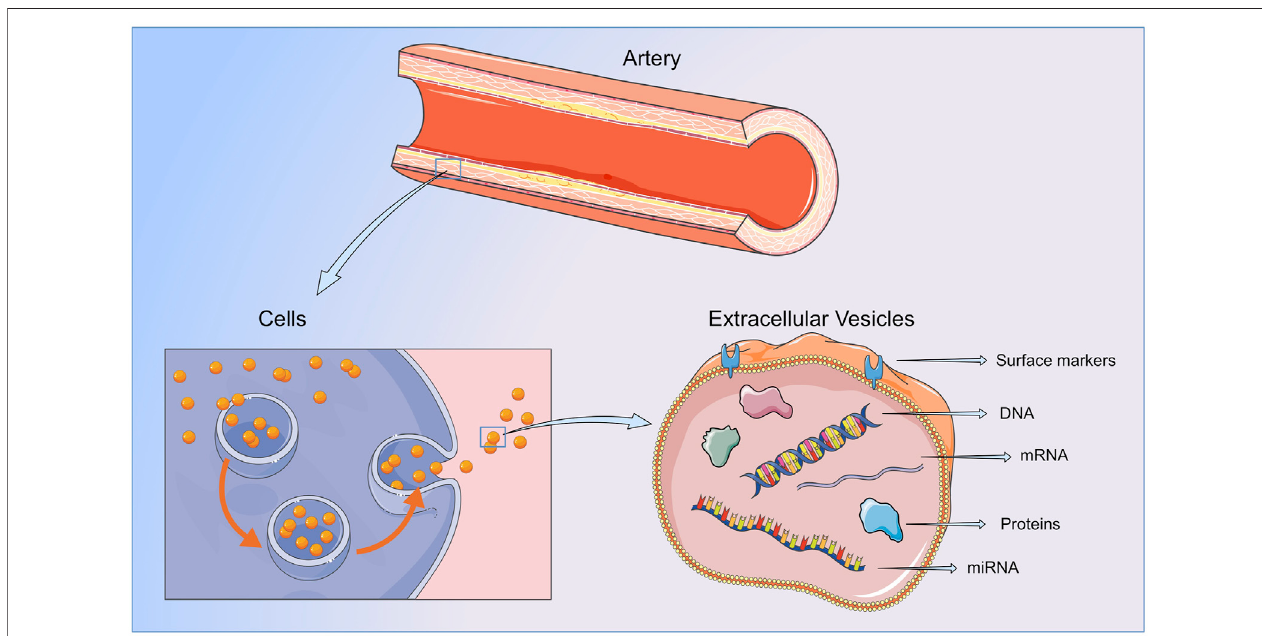
FIGURE 2 | Extracellular vesicles. EVs contain lipids, protein and nucleic acids from the cell or organ of origin and are released to the bloodstream by all cellular componentsofthevasculatureandblood.BytransferringtheircontenttoneighboringordistantcellsorbydirectinteractionwiththeECMscomponents,EVsareableto participate in all the steps of vessel remodeling. Figure created using Servier Medical Art images (https://smart.servier.com).